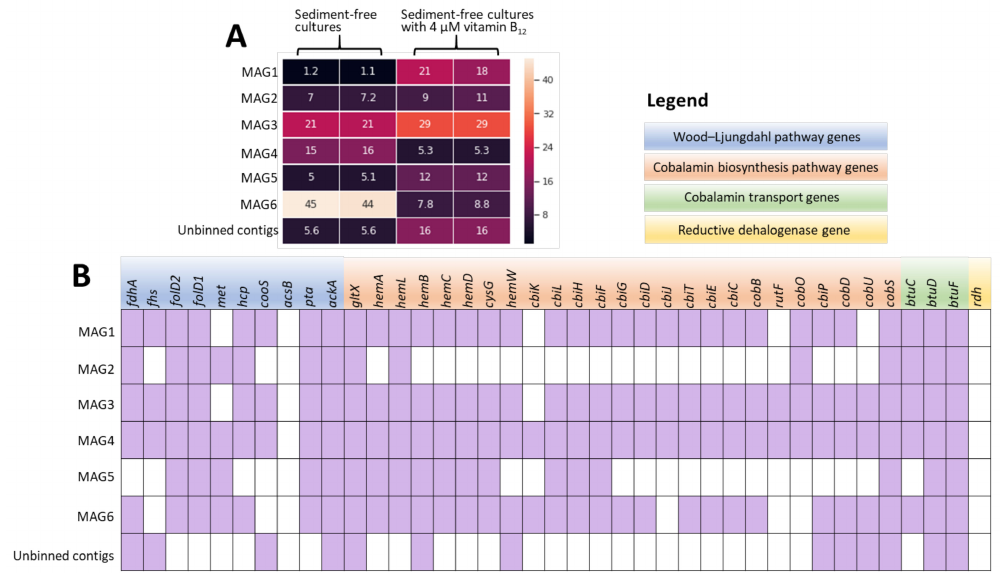
Figure 4. Heatmap of relative abundance (in percent) of MAGs and unbinned contigs assembled from metagenomes of the enrichment cultures with and without addition of 4 µ M vitamin B 12 ( A ) and presence and absence of genes involved in the Wood-Ljungdahl pathway, cobalamin biosynthesis, and transport and reductive dehalogenation (organohalide respiration) in the MAGs and unbinned contigs ( B ). Gene names and encoded proteins are shown in Supplementary Table